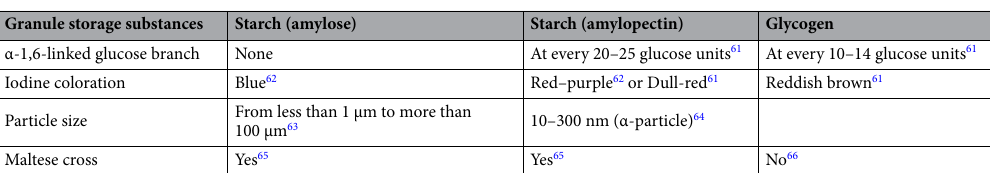
Table 2. Properties of storage glucans with α-1, 4-linked glucose